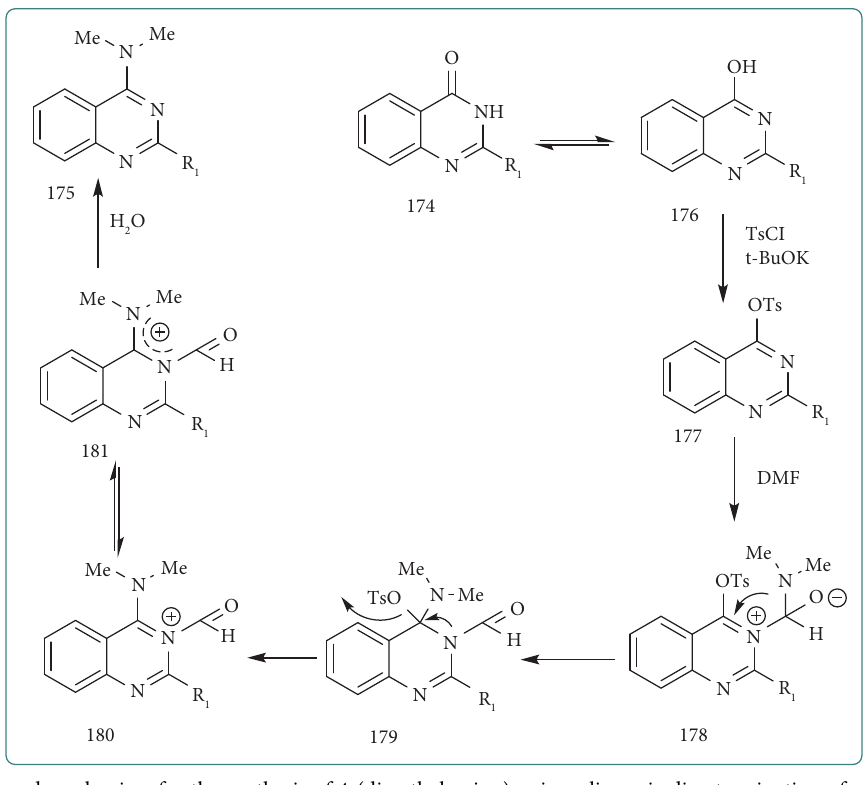
Figure 18: Te proposed mechanism for the synthesis of 4-(dimethylamino) quinazolines via direct amination of